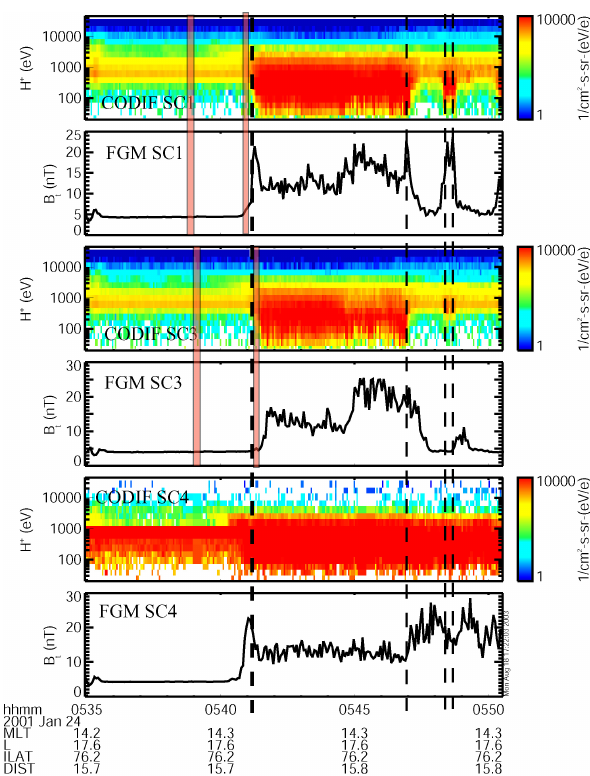
Fig. 1. From top to bottom: Colored spectrogram of the H + differ- ential particle flux and the magnetic field magnitude B from S/C 1, S/C 3, and S/C4, for the time period 05:30–05:50 UT on 24 January 2001. The vertical lines indicate the bow shock crossings of S/C